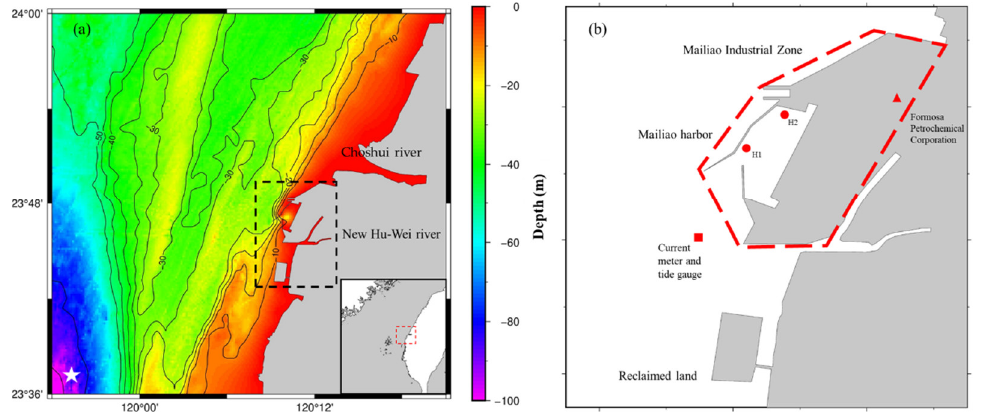
Figure 1. ( a ) Map; bathymetry (in meters); model domain and the adjacent sea. Conductivity, temperature, and depth (CTD) sampling stations (star); black dashed frame covers the main study area. The large-scale setting at the lower-right corner denotes the study area. ( b ) Current meter and tide gauge stations (red rectangle); water quality stations (red solid circles). Red dashed frame indicates the Mailiao industrial Zone.